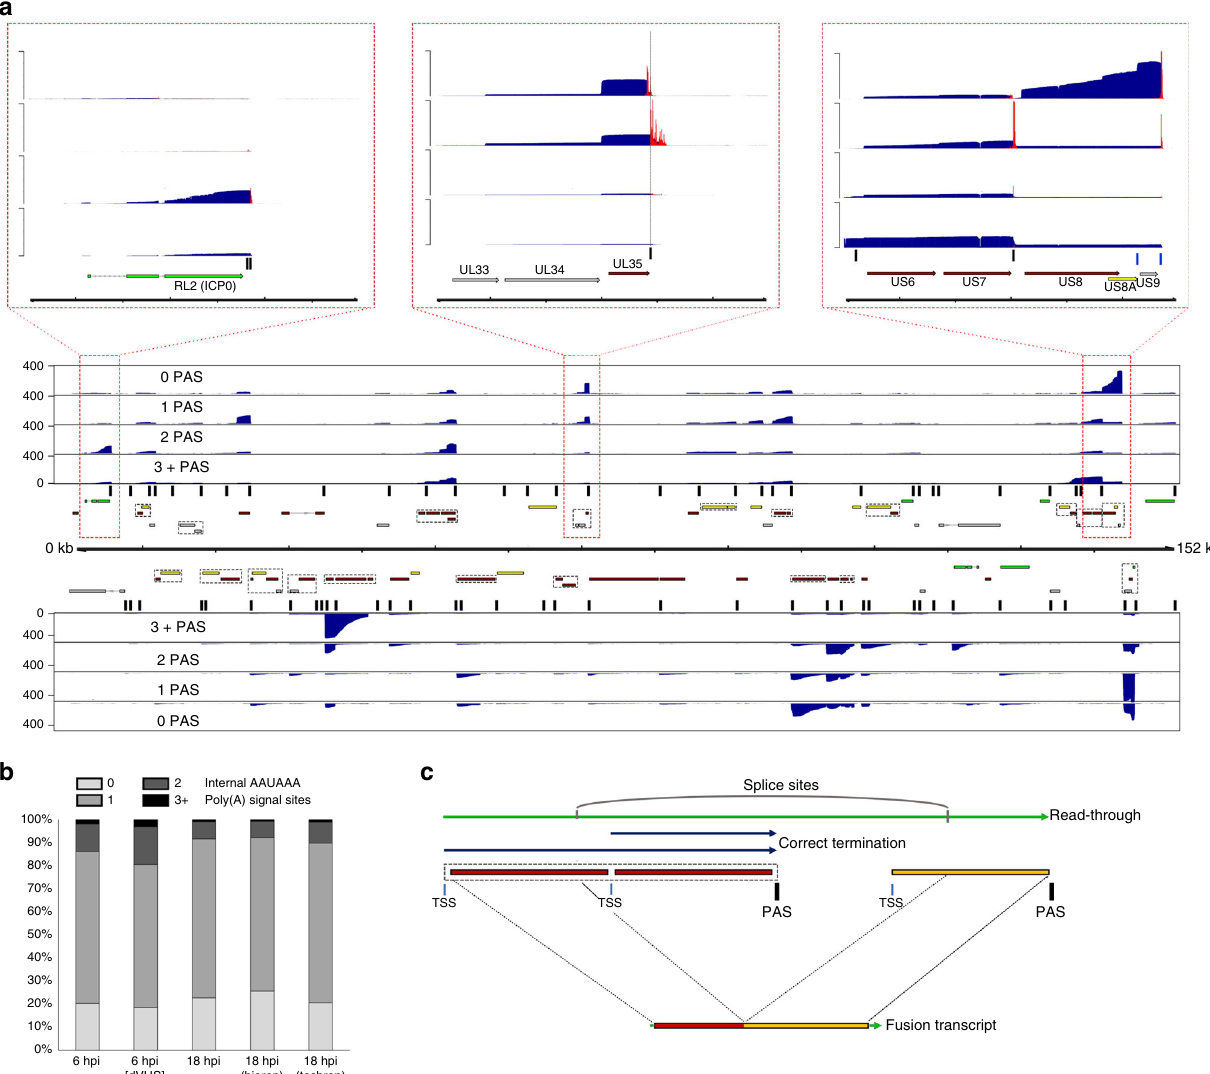
Fig. 5 Detection of read-through transcription from the HSV-1 genome. a HSV-1 sequence reads were segregated according to the number of AAUAAA PAS motifs present and aligned against the HSV-1 genome to produce coverage plots showing the location of mapped reads. Here, complex (multiple overlapping ORFs) gene arrays are identi fi ed by cross-hatched boxes, while the locations of AAUAAA motifs are indicated by vertical black bars. The three inset boxes correspond to the red cross-hatched areas of the genome that exemplify (left) the presence of two AAUAAA motifs at the 3 ′ end of the RL2 transcript, (center) the position of pTTS sites relative to AAUAAA motifs (black vertical line), and (right) usage of the non-canonical AUUAAA motif (blue vertical line). pTTS estimates are shown as red overlays on the inset coverage plots. b HSV-1 transcription termination is generally initiated by recognition of a canonical (AAUAAA — dark gray) PAS sequence. Evidence of read-through transcription includes the presence of multiple AAUAAA motifs within a transcript and is observed in a small proportion 1 – 3% of HSV-1 mapping direct RNA-seq reads. c Transcription of HSV-1 genes initiates at transcription start sites (blue vertical line) and typically terminates shortly after traversing a canonical (AAUAAA) PAS sites (black vertical line). In rarer cases, termination does not occur and transcription extends further downstream as read-through until another PAS site is used. These extended transcripts may be subject to internal splicing which can give rise to fusion